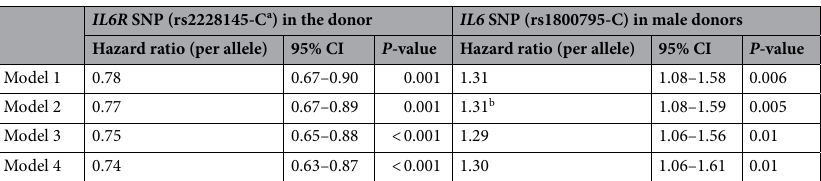
Table 2. Associations of interleukin-6 and interleukin-6 receptor polymorphisms in the donor with rejection following kidney transplantation. Data are presented as hazard ratio with 95% confidence interval (CI) and P -value. Model 1 crude model. Model 2 adjusted for model 1 plus donor characteristic’s: donor age, donor sex, donor blood type, and donor origin. Model 3 adjusted for model 1 plus recipient characteristic’s: recipient age, recipient sex, recipient blood type and dialysis vintage. Model 4 adjusted for model 1 plus transplant characteristic’s: cold and warm ischemia time, the total HLA-mismatches, and the occurrence of delayed graft function (DGF). a Previously rs8192284. b For the IL6 SNP (rs1800795-C), model 2 could not be adjusted for donor sex since this was a subgroup analysis for male